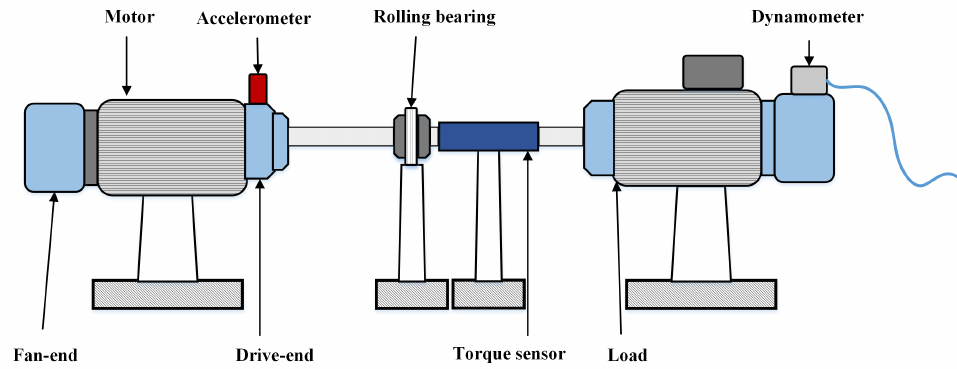
Figure 4. The bearing experimental setup of CWRU. Table 2. Distribution of rolling bearing